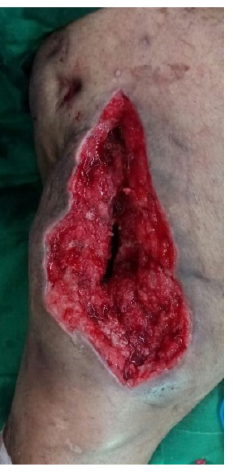
Figure 4. Wound after re- debridement